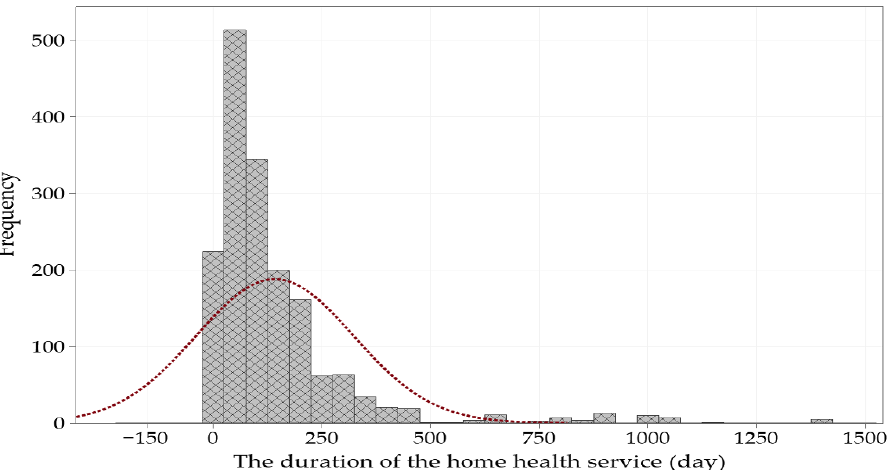
Figure 1. Histogram with fit lines of the dependent variable.